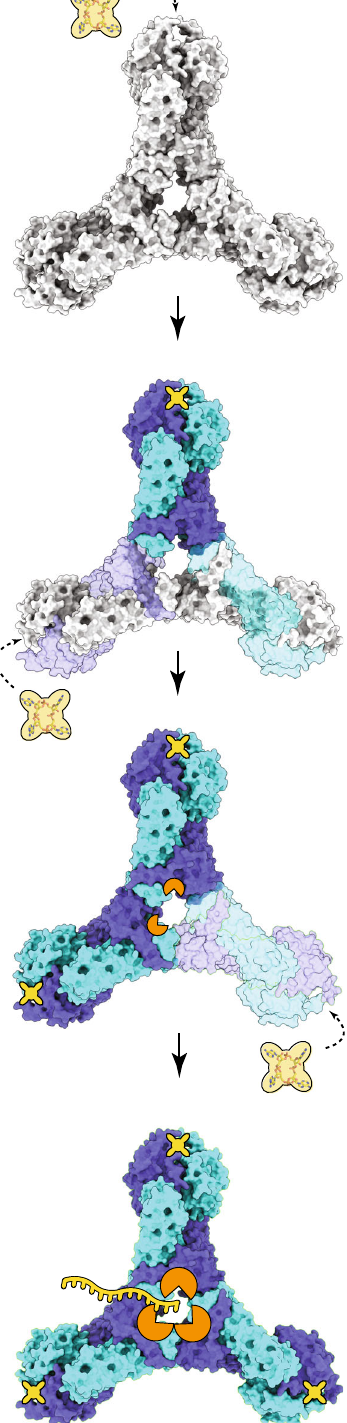
Fig. 7 Model for SisCsx1 RNase catalysis activation by cOA 4 . The binding of cOA 4 (tetralobal shape) by the CARF domains fully activates the fi rst dimer (strong blue and strong sky blue) and induces a conformational change through the HTH to the HEPN domains of two adjacent monomers (light blue and light sky blue) favoring cOA 4 binding in any of their available cOA 4 binding sites. The binding of the second cOA 4 molecule fully activates the second dimer (strong blue and strong sky blue), promoting some initial RNase activity and triggering conformational changes in the two monomers of the third dimer (light blue and light sky blue) leading to the binding of the third cOA 4 molecule and the full RNase